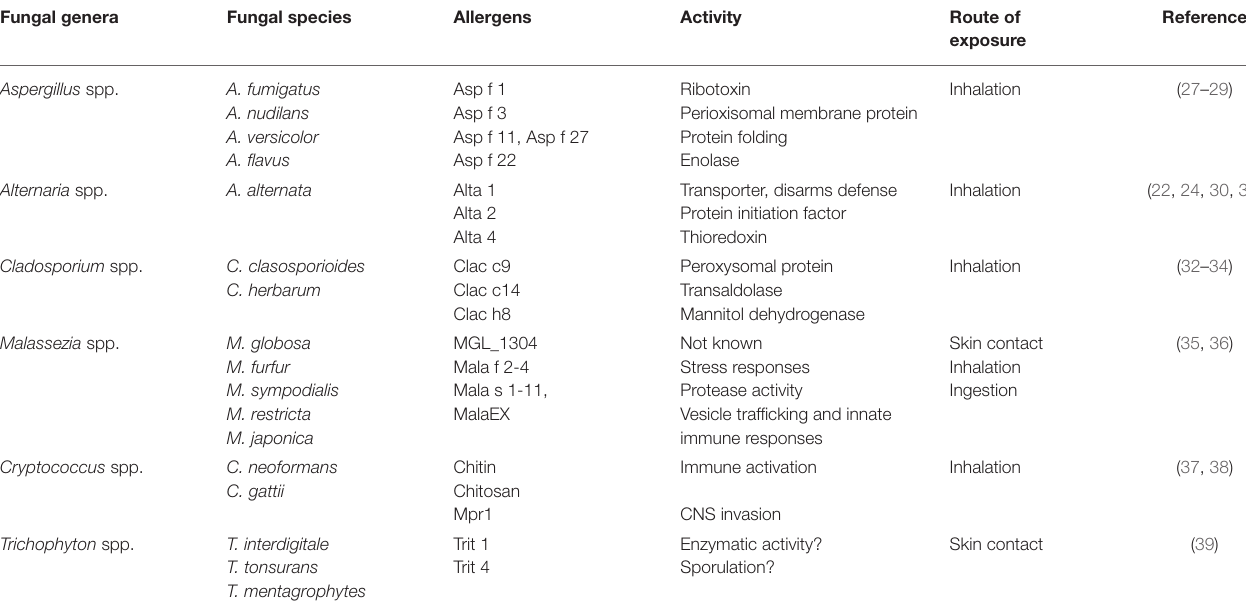
TABLE 1 | Some of the fungal species associated with allergic asthma via various routes of sensitization. Fungal genera Fungal species Allergens Activity